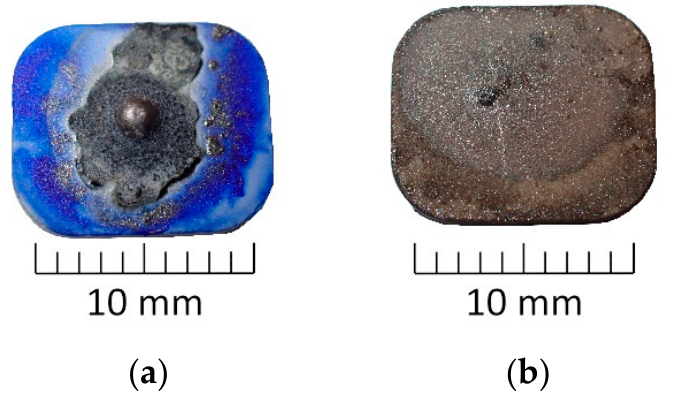
Figure 5. Condition of the sample during examination under the heating microscope: ( a ) after analysis for LCO-C; ( b ) after analysis for LFP-C.